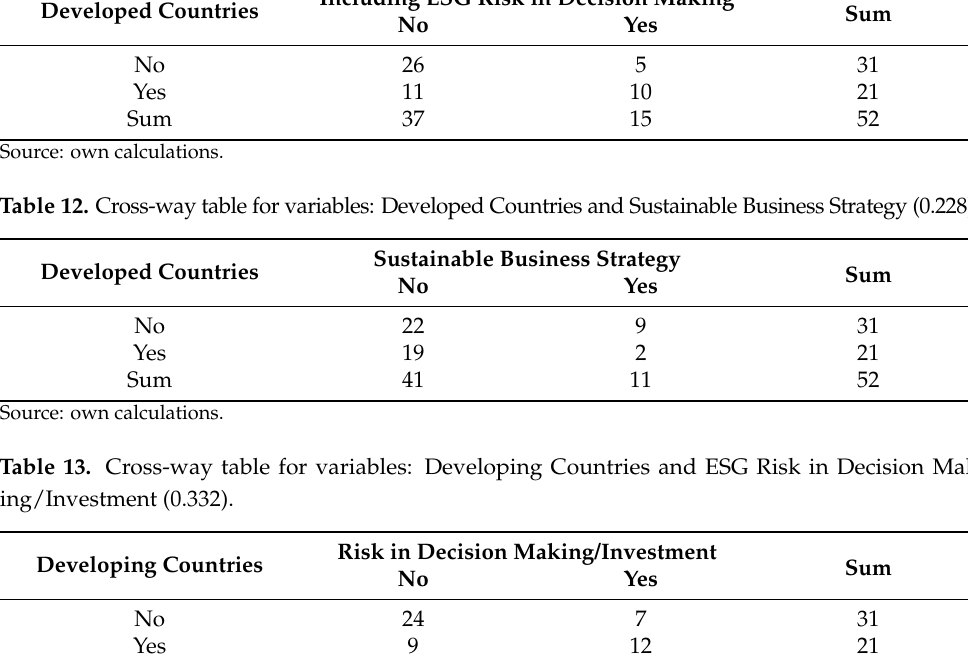
Table 11. Cross-way table for variables: Developed Countries and Including ESG Risk in Decision Making (0.323). Developed Countries